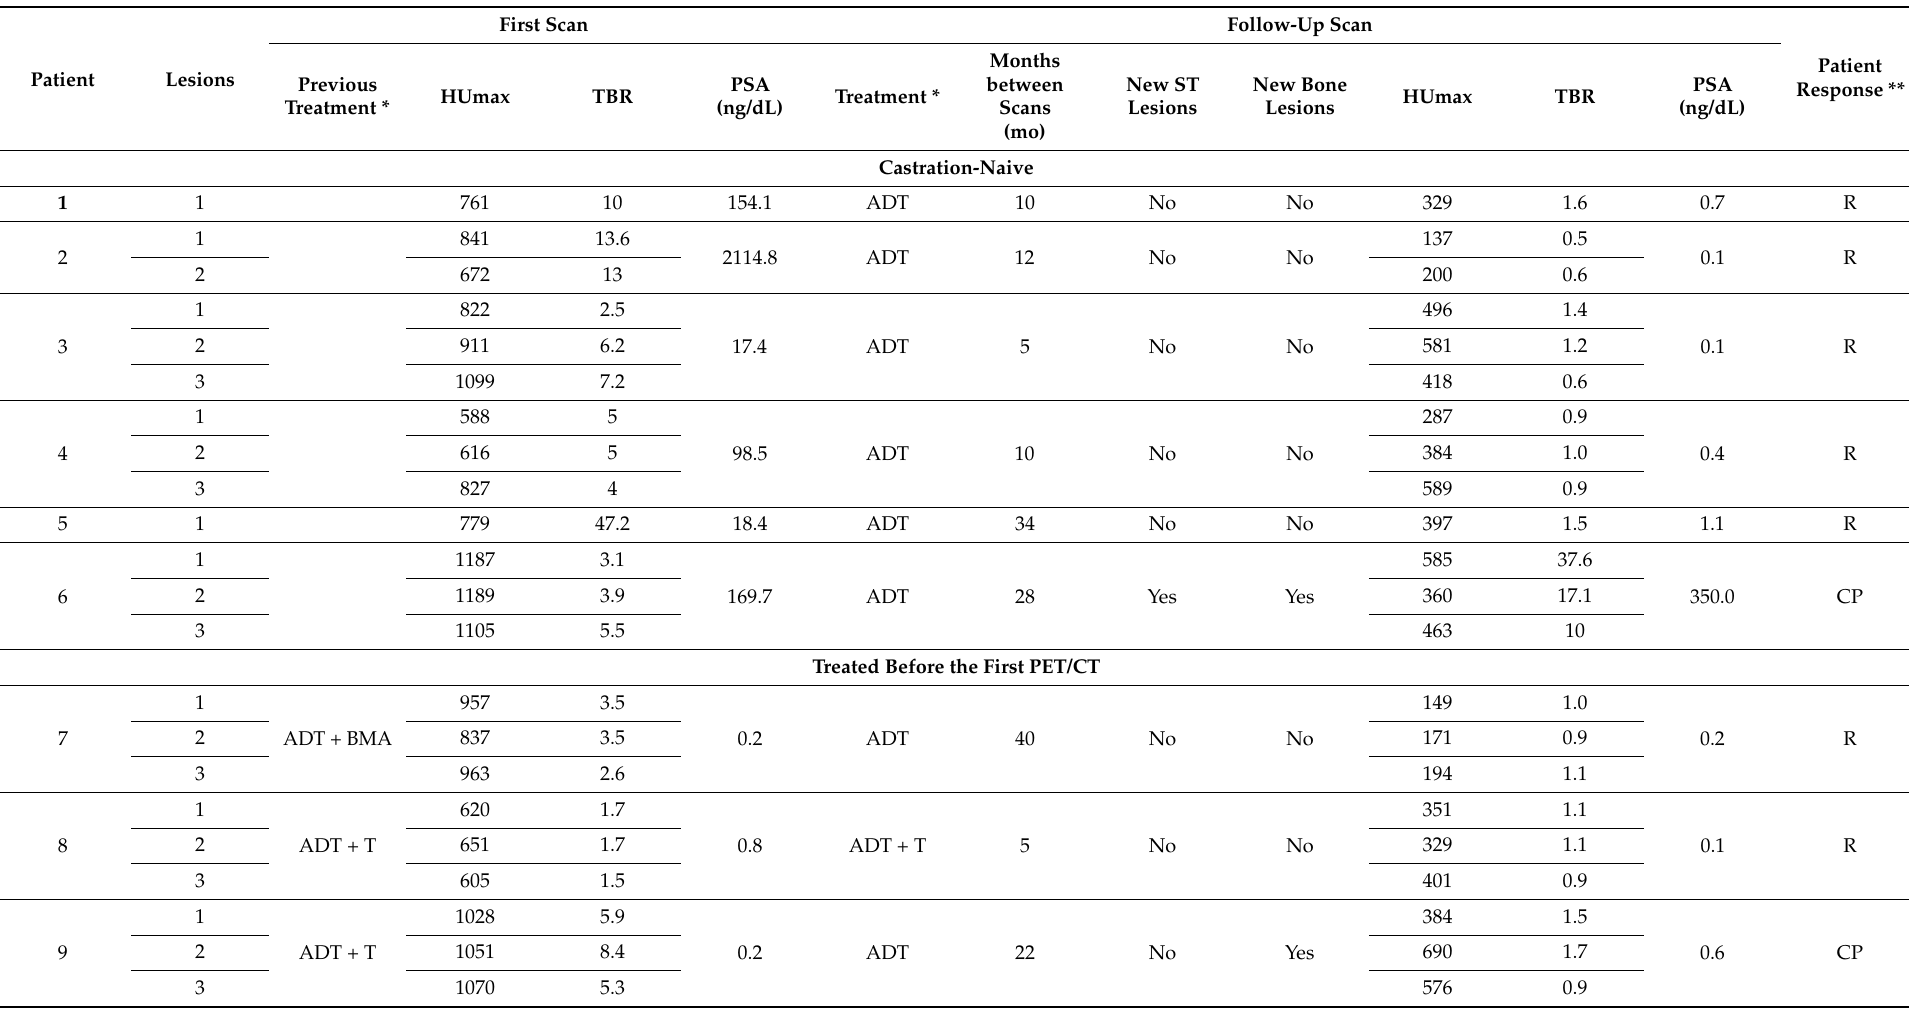
Table 1. PSA values, findings on PET/CT scans, and response to androgen deprivation therapy (ADT). Humax, maximum Hounsfield unit; TBR, tumor-to-background ratio; PSA, prostate-specific antigen; ST, soft tissue; AD, androgen deprivation therapy; T, Taxotere; BMA, bone-modifying agents; OE, orchiectomy; CP, clinical progression; R, response to therapy. * Treatment consisted of androgen deprivation therapy, Taxotere, bone-modifying agents, and orchiectomy. ** Patient response was either clinical progression or response to therapy. First Scan Follow-Up Scan Patient Lesions